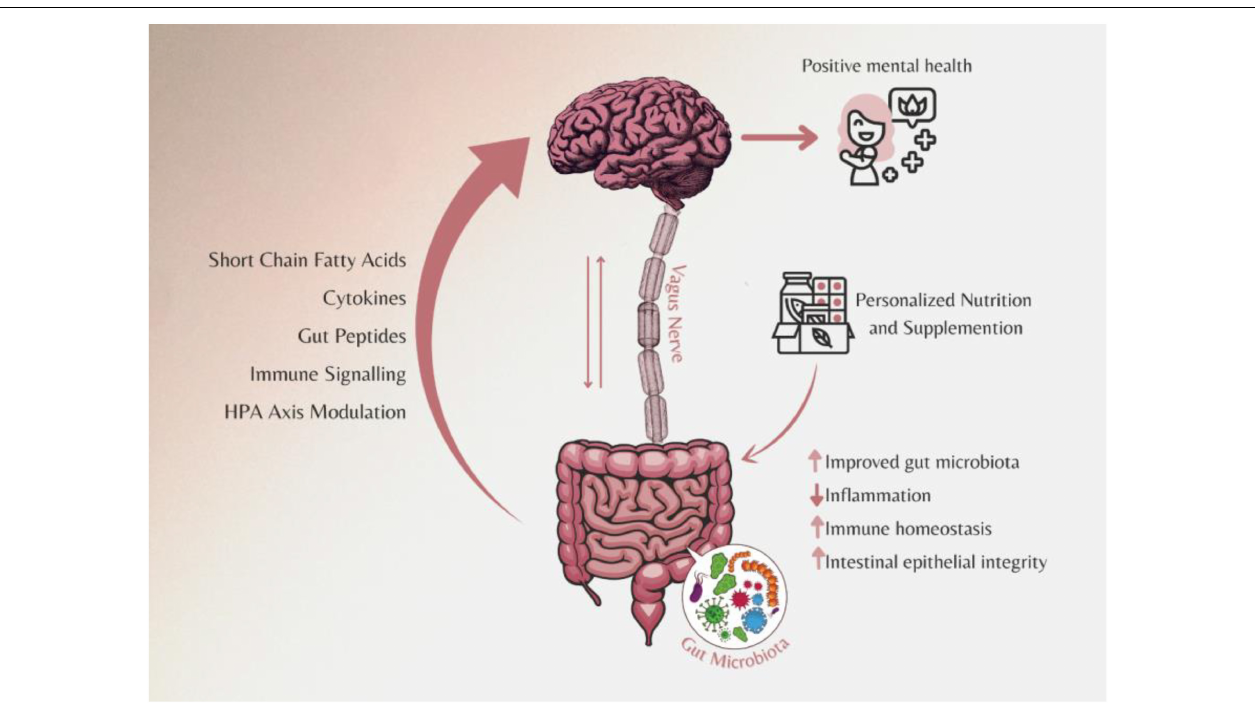
FIGURE 2 | Personalized nutritional strategies including diet, prebiotics, and probiotics combination based on the individual’s gut microbiome can improve mental health